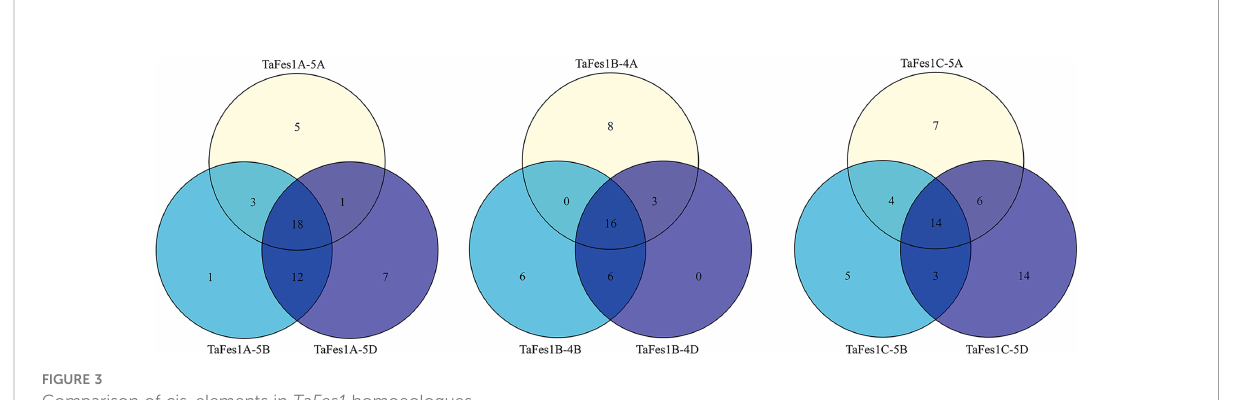
FIGURE 3 Comparison of cis-elements in TaFes1